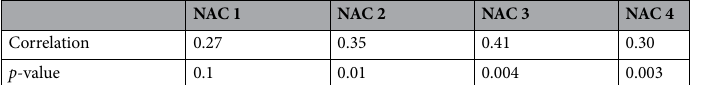
Table 2. The correlation coefficients (Pearson and Spearman) between the RMC and the relative tumour diameter, echogenicity, tumour stiffness and vascularity, p-value is given in brackets.